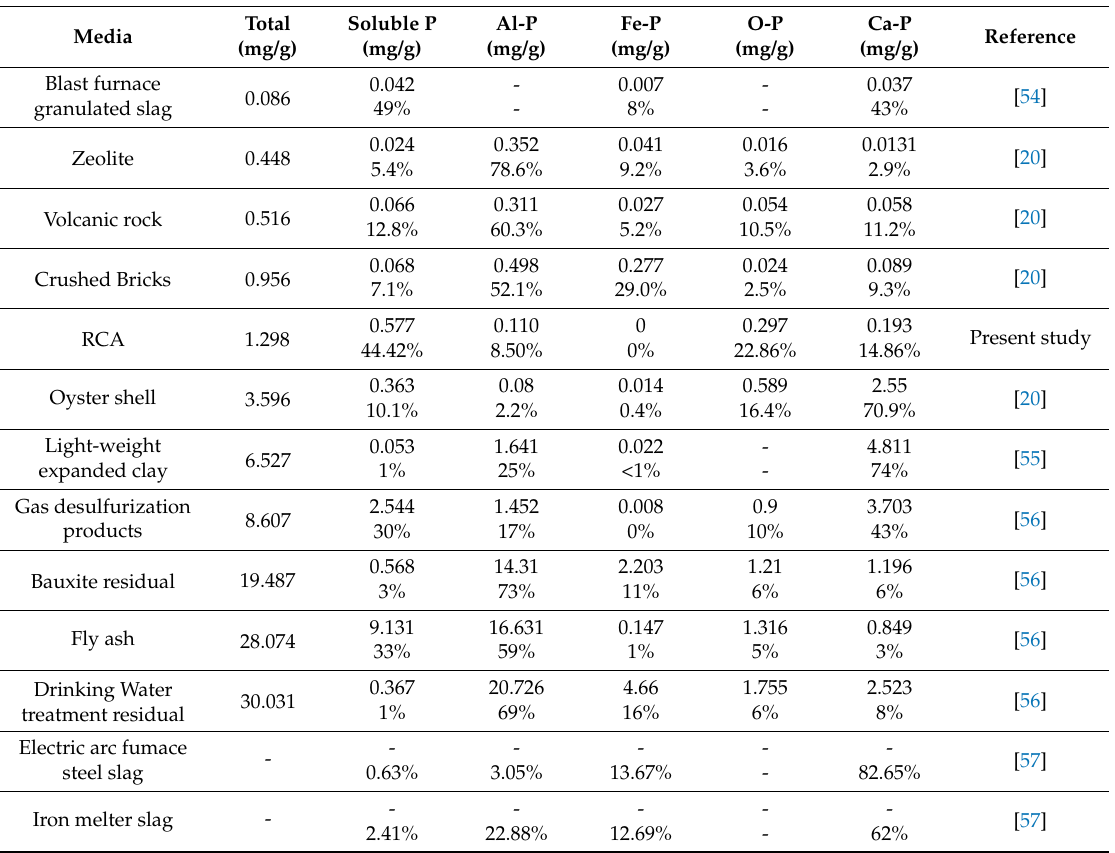
Table 11. P specification of various saturated